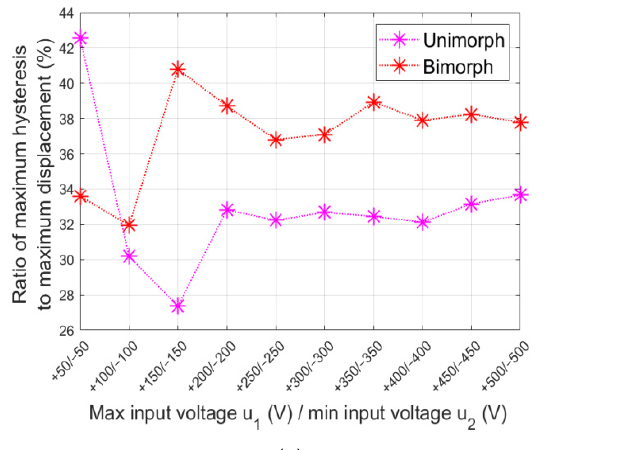
Figure 9. Comparison of the maximum hystereses ( a ) for the unimorph, and ( b ) for the bimorph.